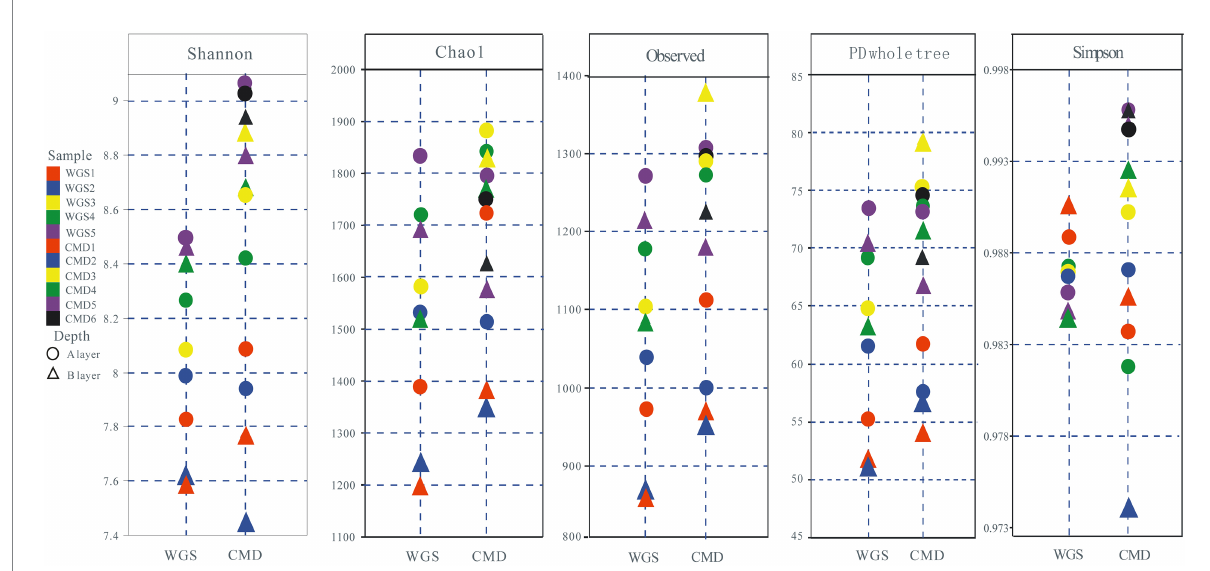
FIGURE 2 Alpha diversity of soil bacteria from Mount WGS and Mount CMD in karst graben basin of Yunnan-Kweichow Plateau.